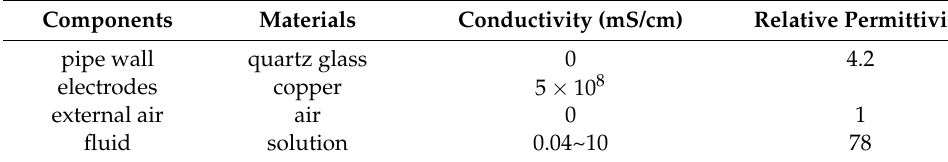
Table 1. The properties of the model